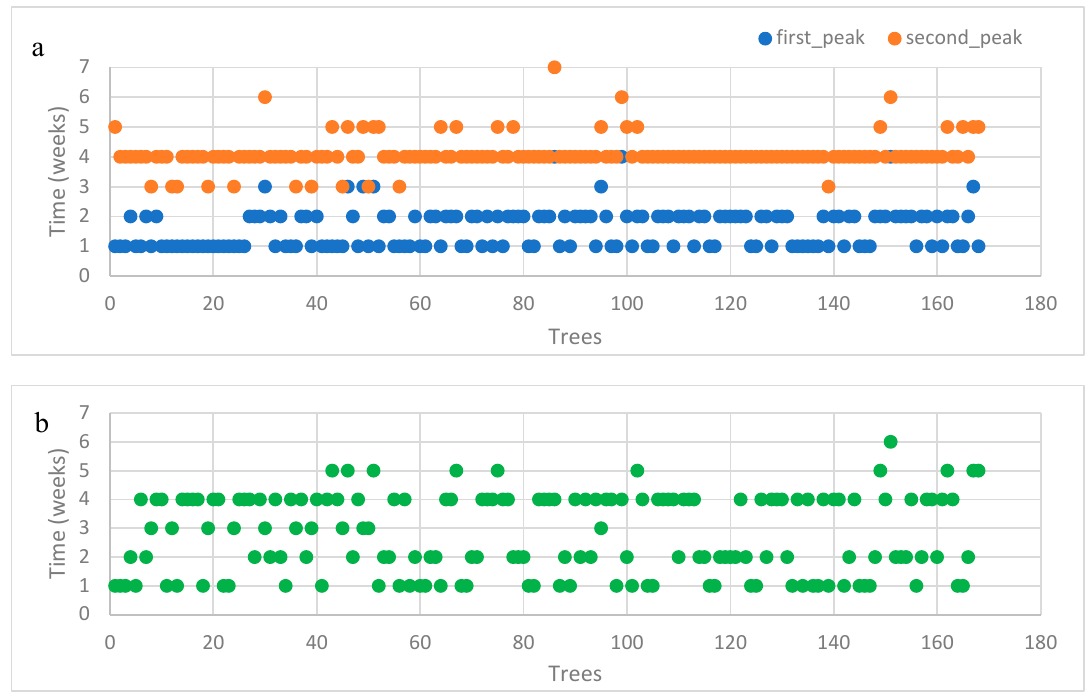
Figure 13. ( a ) Plot displaying the weeks in which a peak flowering event was noted and ( b ) plot displaying the week of the largest flowering event for 168 trees in which two flowering peaks were recorded.